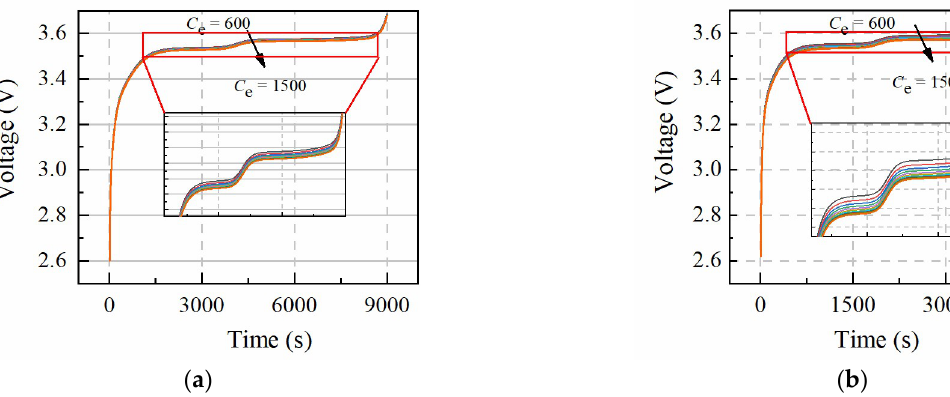
Figure 5. Sensitivity curves of battery terminal voltage to C e under different charging rates. ( a ) Sen‑